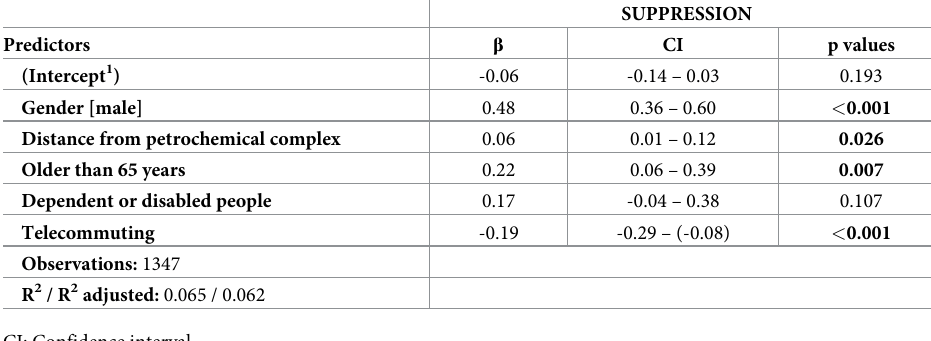
Table 14. Regression analysis relating to suppression strategy in the ERQ.